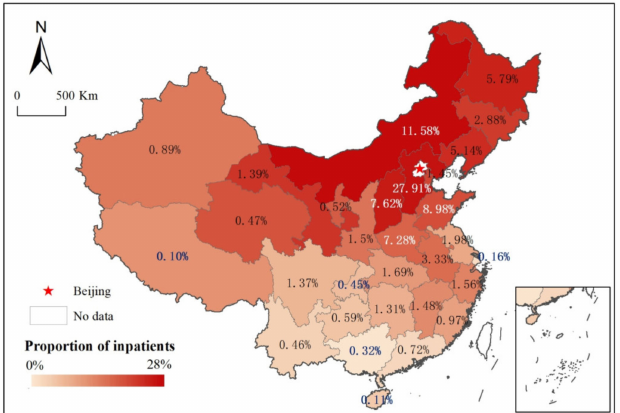
Figure 2. Proportion of cross-regional patients travelling from provinces across the country to